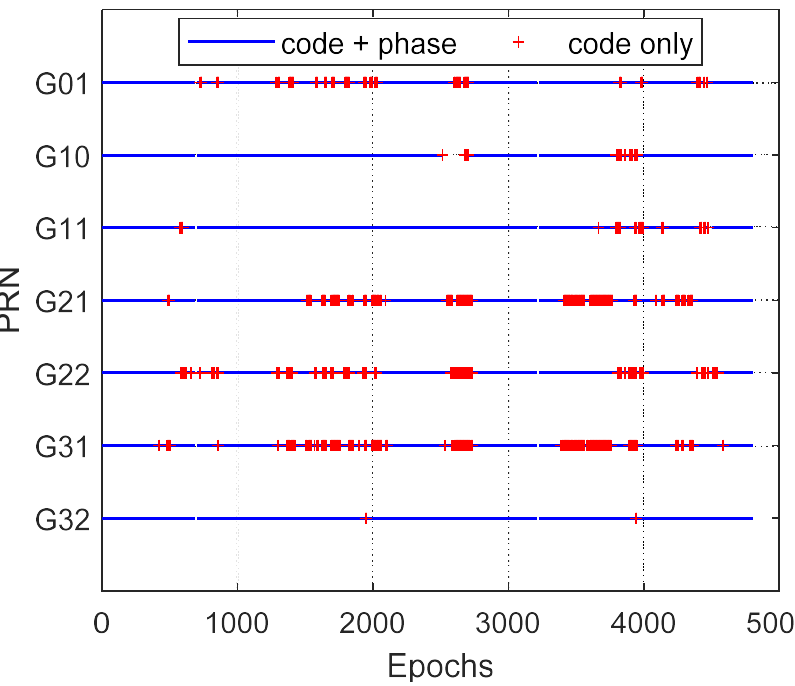
Figure 6. Visibility of pseudorange (code) and carrier phase observations of the selected satellites. Table 1. Number of epochs of the code and carrier phase observations, counted per satellite, and the corresponding percentages relative to the total epochs.